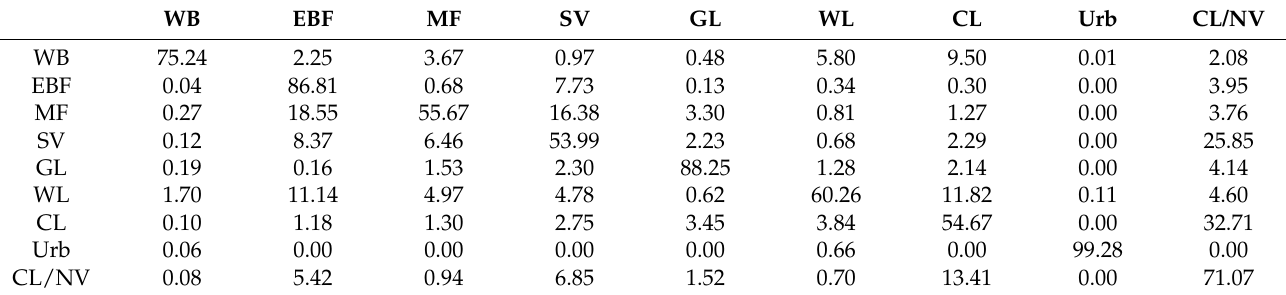
Table 1. Land-use transformation matrix (%).